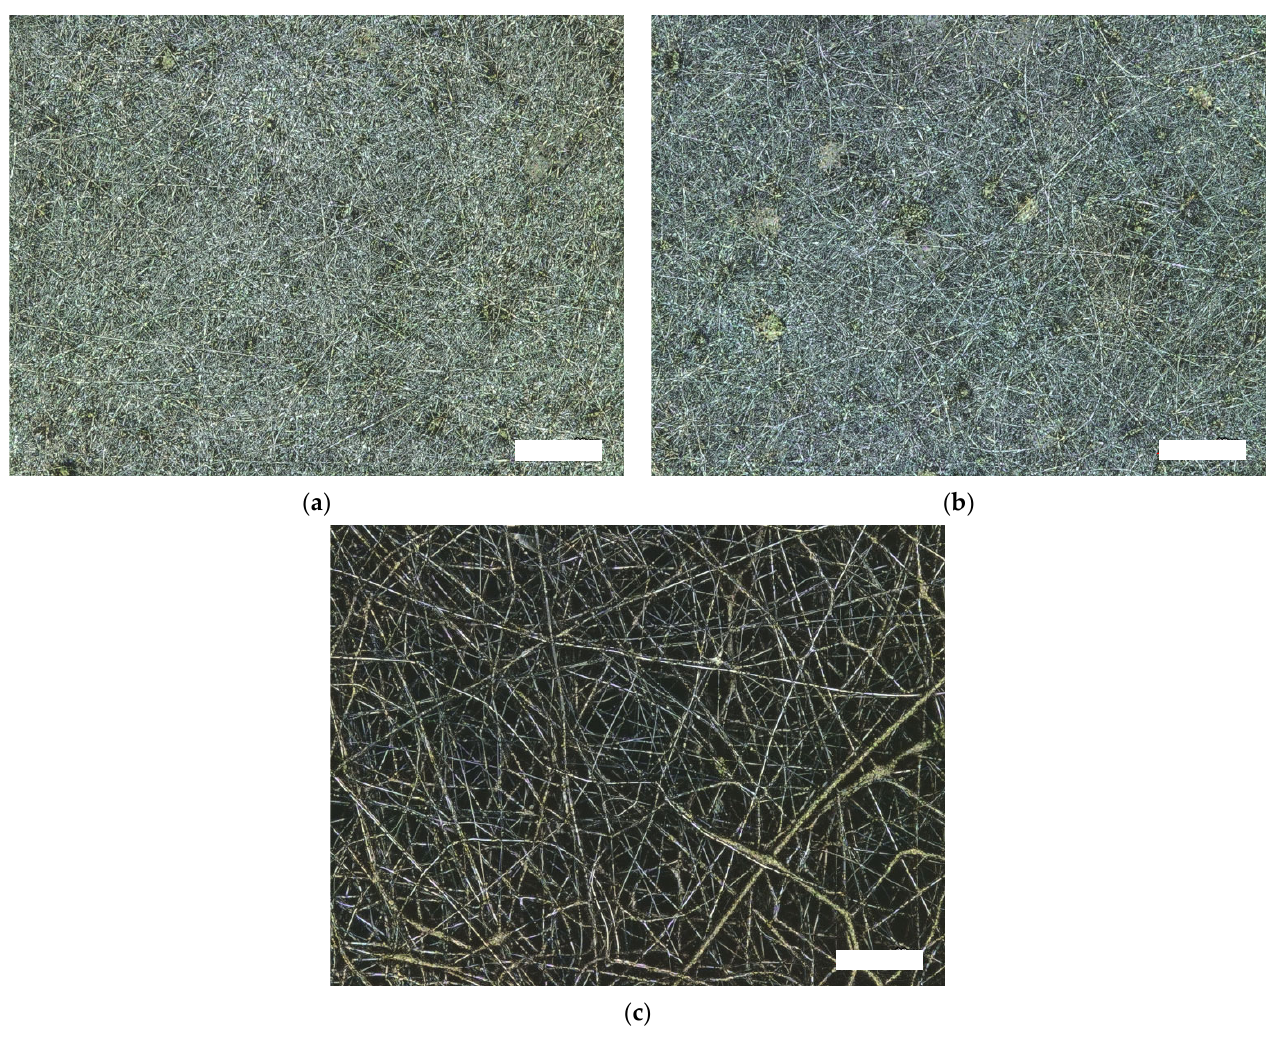
Figure 3. Confocal laser scanning microscope (CLSM) images of the magnetic nanofiber mats: ( a ) 16 wt% PAN with 65 kV voltage and 40 min ultrasonic bath; ( b ) 16 wt% PAN with 80 kV voltage and 40 min ultrasonic bath; ( c ) 16 wt% PAN and 80 kV voltage without ultrasonic bath. Scale bars indicate 20 μ m.